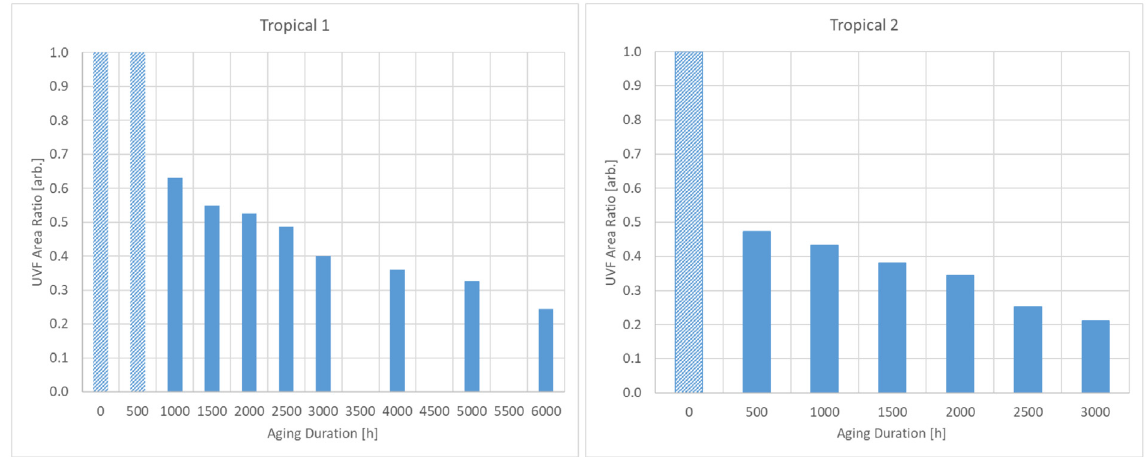
Fig. 5. UVF area ratio analysis for accelerated aging procedures Tropical 1 & Tropical 2.